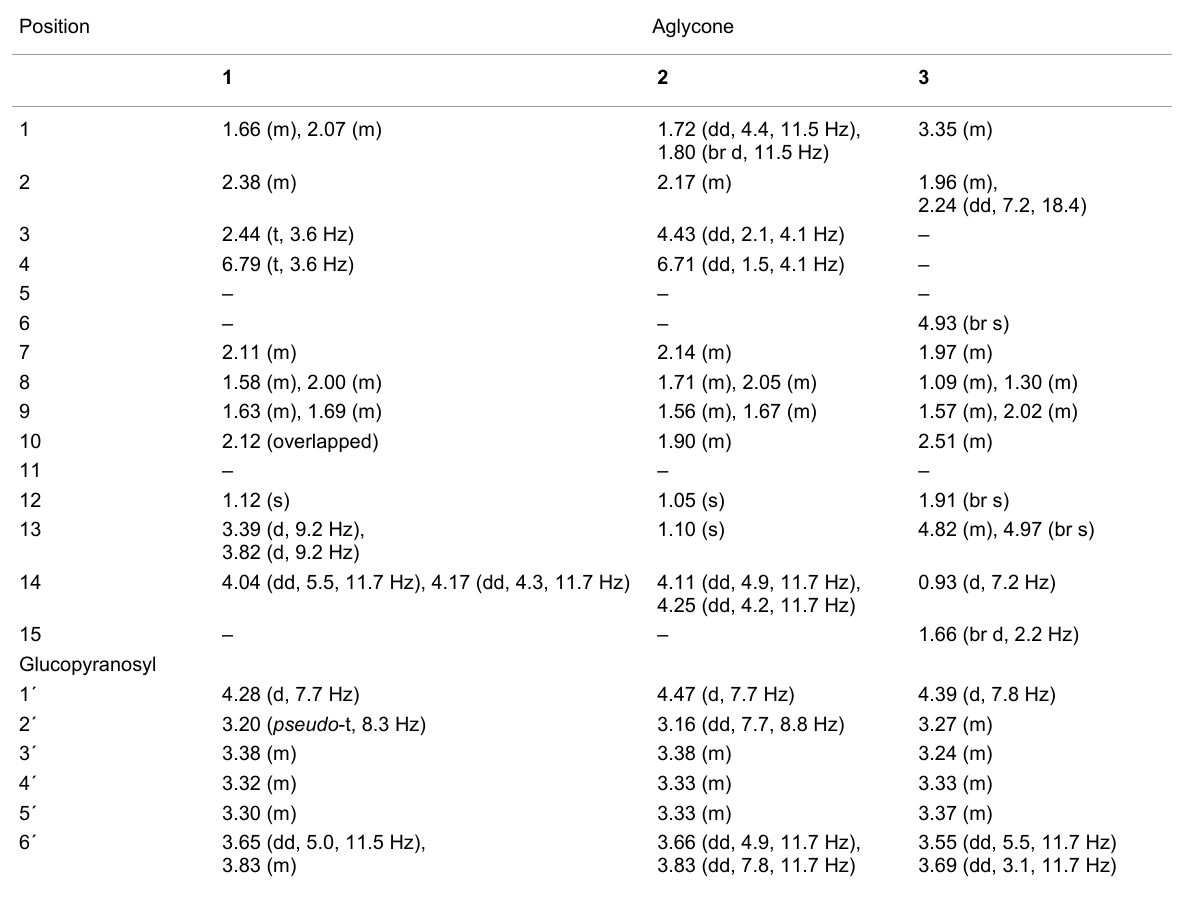
Table 2: 1 H NMR data [400 MHz, (CD 3 ) 2 CO] of compounds 1 – 3